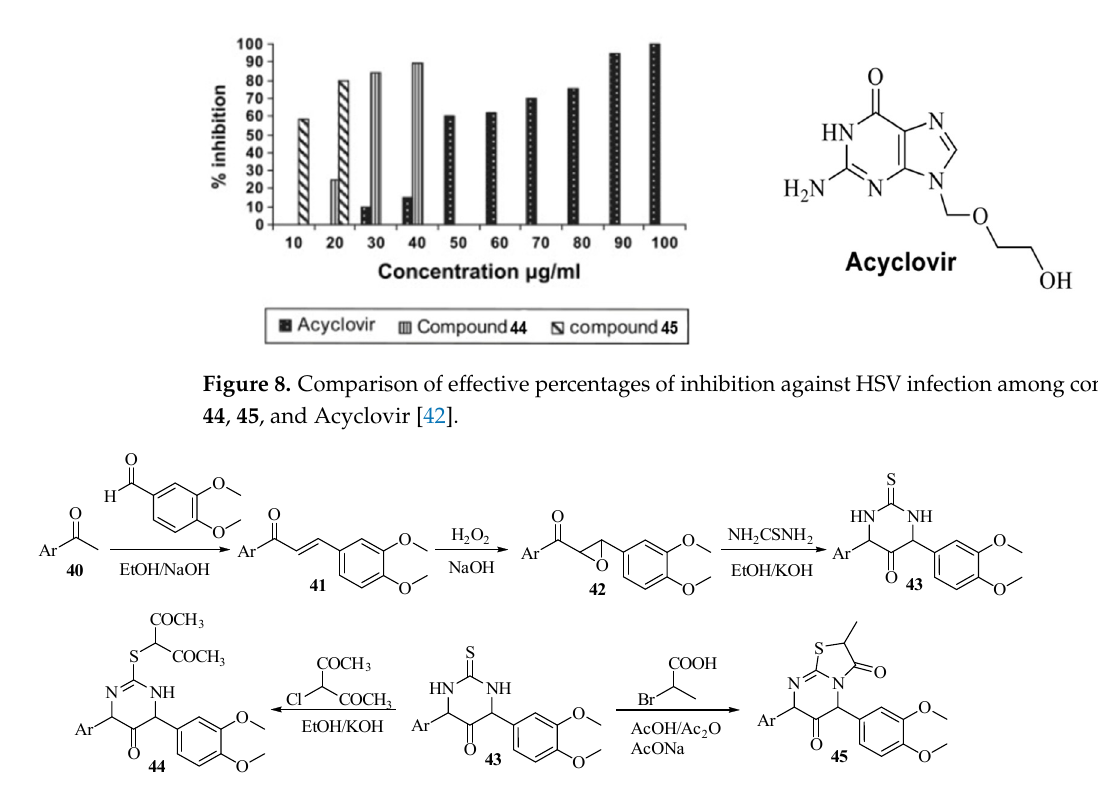
Scheme 10. Synthesis of pyrimidine derivatives as anti-HSV agents.